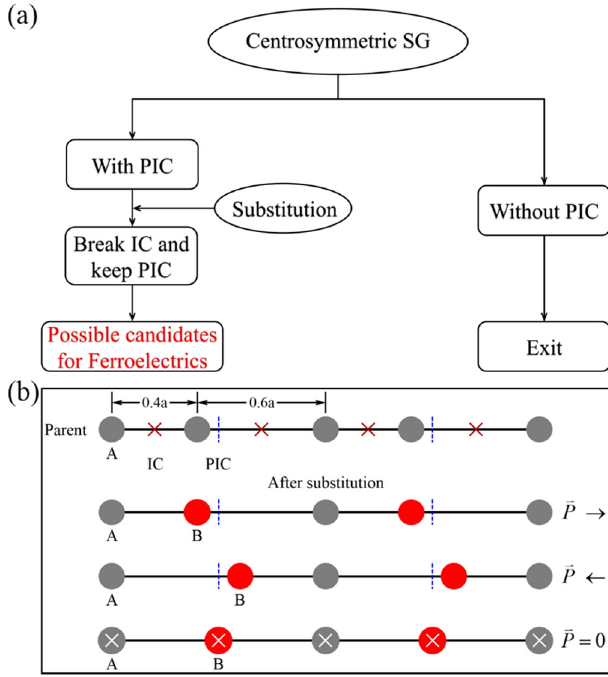
Fig. 1 Flow chart and diagrammatic sketch of our method. a The fl ow chart of our method for designing new ferroelectrics. b A simple one-dimensional model system to illustrate the idea of our method. The position 0.5a is the pseudo inversion centers (PICs) and denoted by the vertical dashed line. The true inversion centers (TICs) are denoted by “ × ” . “ SG ” is an abbreviation for “ space group be obtained. Figure 1a shows a chart for the general strategy of designing new FEs. Our method is illustrated clearly with a simple one-dimensional toy model (see Fig. 1b). Assuming that there is a one-dimensional chain with two atoms of the same type (represented by A) in a unit cell, the two atoms locate at positions 0.0 and 0.4, respectively. Then, one can fi nd two TICs denoted by the crosses within a unit cell before any substitution. If replacing an A atom by a B atom in the unit cell, all the TICs disappear, resulting in a possible polar structure with polarization P along the left or right directions. However, there is a PIC at position 0.5 even after the substitution. When moving the B atom to the center of the unit cell, the PIC will become a TIC. From the above discussion,